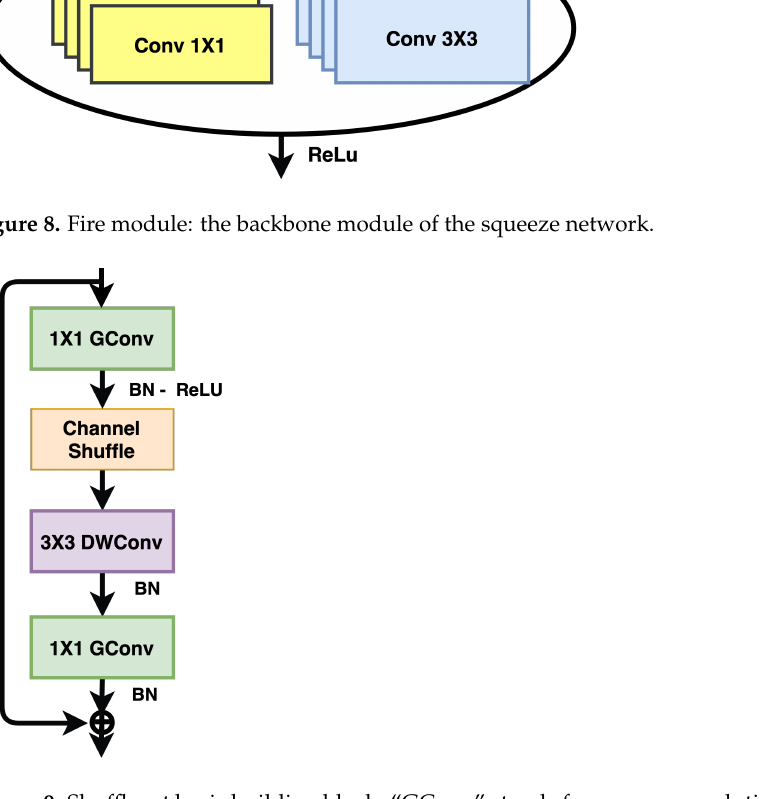
Figure 9. Shufflenet basic building block. “GConv” stands for group convolution, and “DWConv” denotes depth-wise